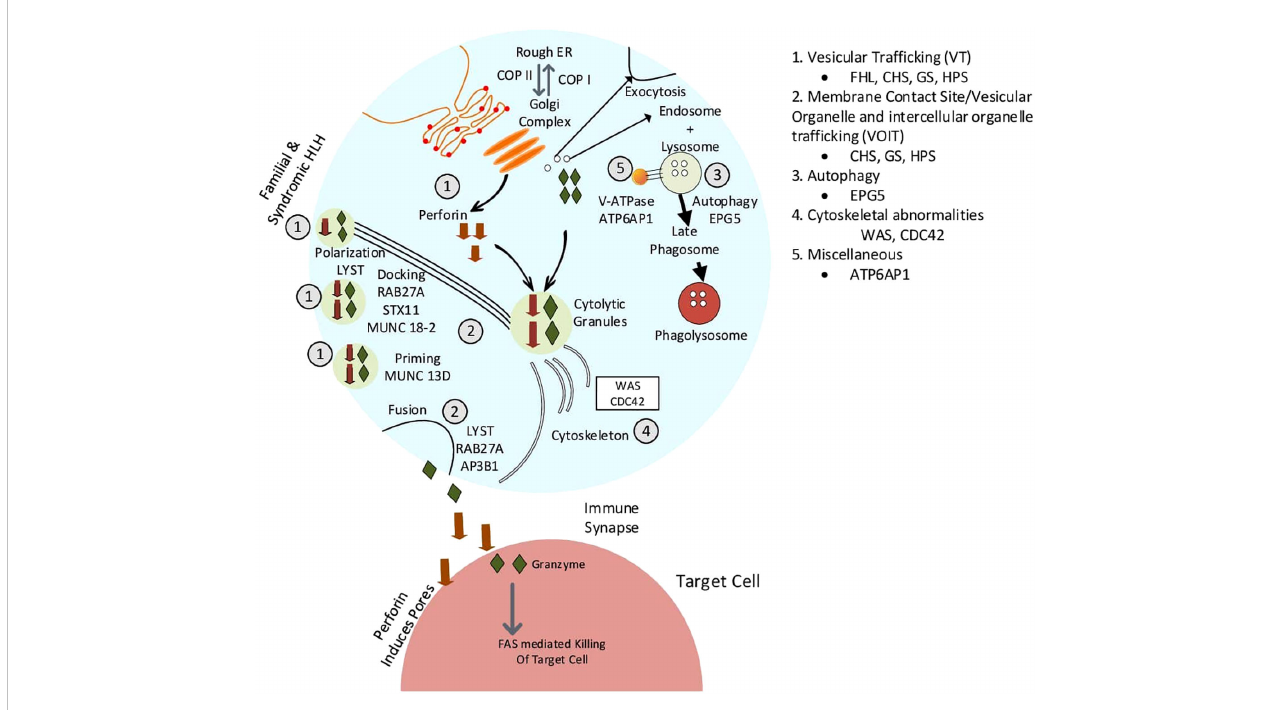
FIGURE 2 Pictorial representation of defects in membrane traf fi cking and associated